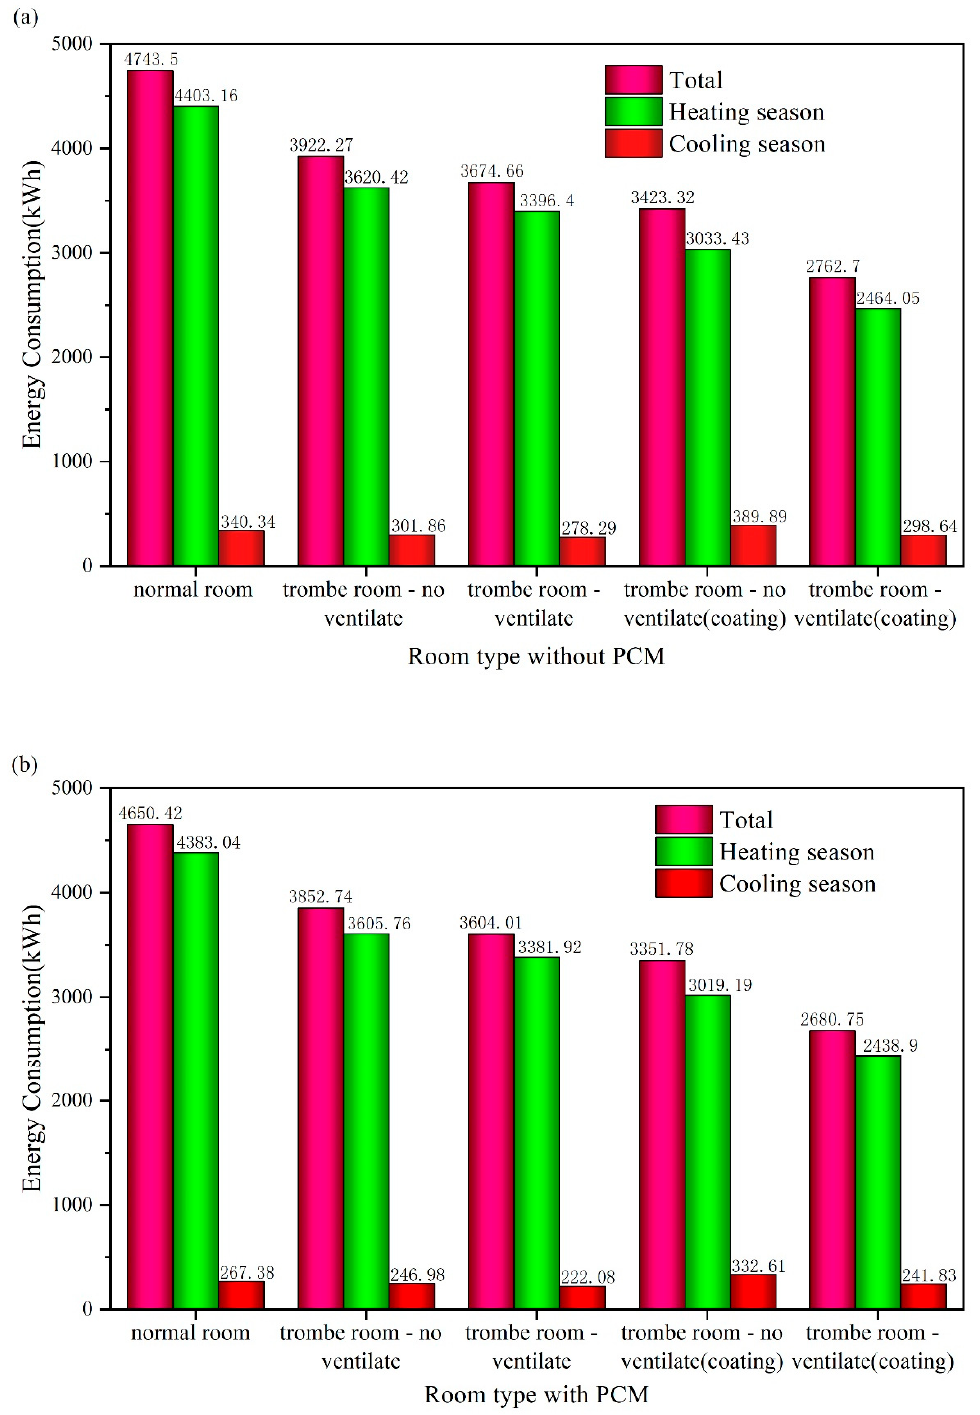
Figure 4. The energy consumption of different room types: ( a ) without PCM and ( b ) with PCM.